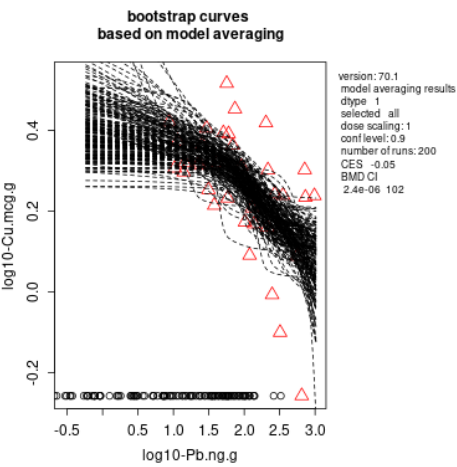
Figure 4. Benchmark dose modeling of the liver Cu levels as a response to the internal Pb dose–liver tissue level ( µ g/g) using a model averaging method with 200 iterations, PROASTweb70.1 software (https://proastweb.rivm.nl/). The red triangles represent the medians.